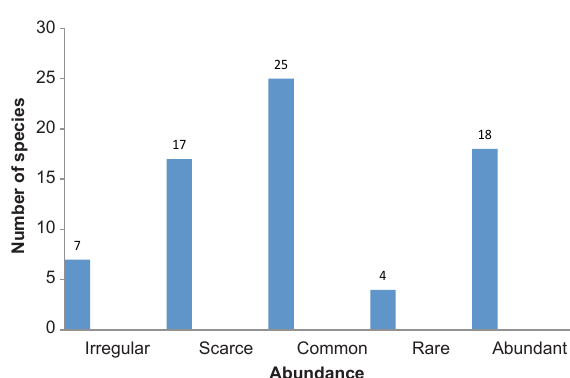
Figure 1. Relative abundance of bird species in Dalma Wildlife